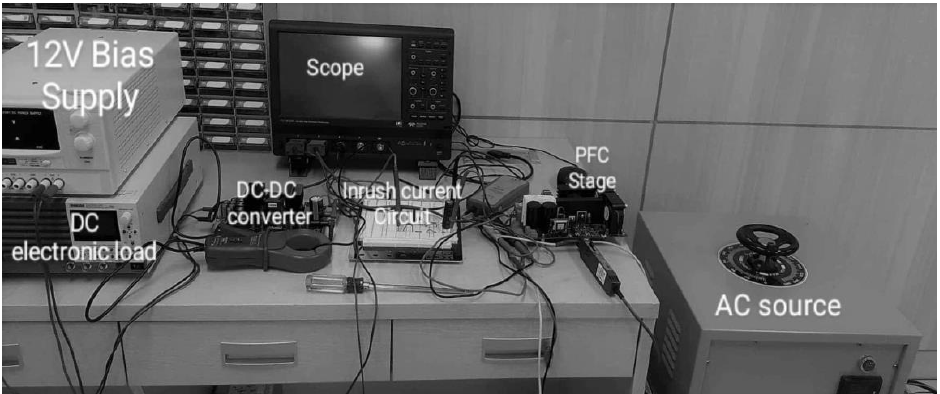
Figure 17. Experimental setup of DC–DC converter circuit with inrush current mitigation circuit.